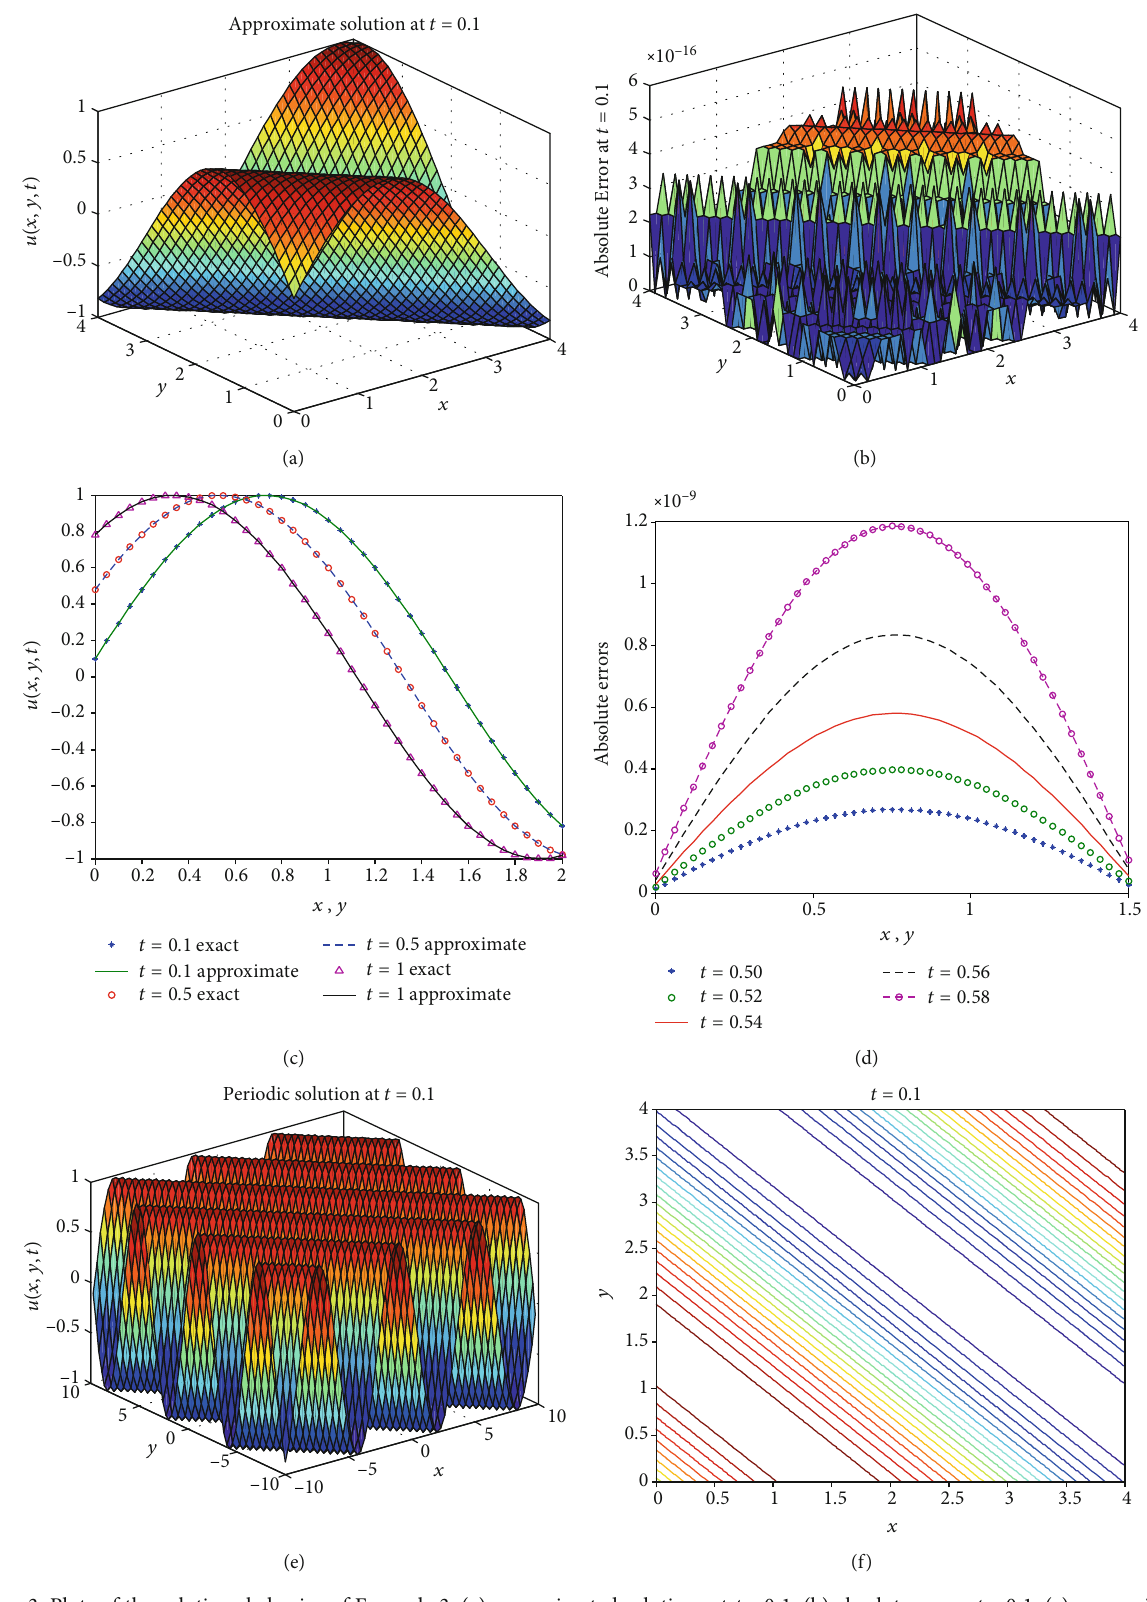
Figure 3: Plots of the solutions behavior of Example 3: (a) approximated solutions at t = 0 : 1 ; (b) absolute errors t = 0 : 1 ; (c) comparison of exact and approximated solutions for t = 0 : 1 , 0.5, 1; (d) comparison of absolute errors for di ff erent values of times t = 0 : 5 , 0.52, 0.54, 0.56, 0.58; (e) the periodic nature of the solution, and (f) the soliton at t = 0 : 1